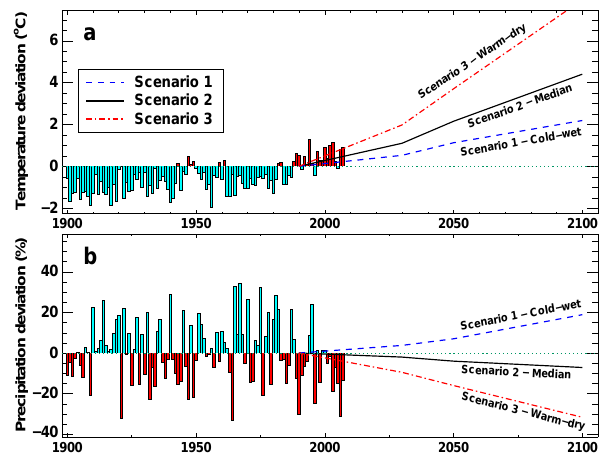
Fig. 6. Deviations of annual (a) mean air temperature and (b) precipitation sums from the period 1980-2000. Measured data for the 20th century are displayed by bars, annual trends as assumed by Scenarios 1-3 (Table 1) are shown until 2100. Fig. 5. Validation of the coupled ice flow and surface mass balance model over the 20th century using field data. Comparison of observed and calculated glacier surface on a longitudinal profile in 1959 and 2007. Model runs were initialized in 1874 (Rhone) and in 1938 (Silvretta).